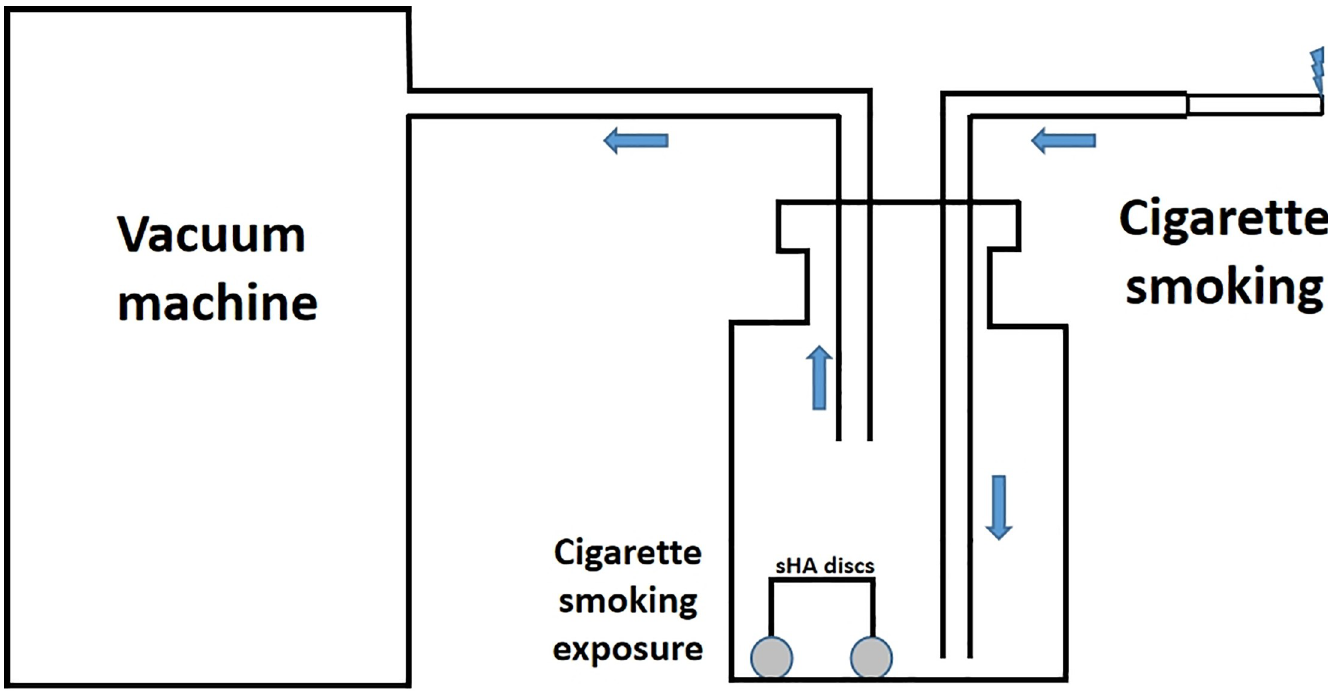
Fig 2. The smoking